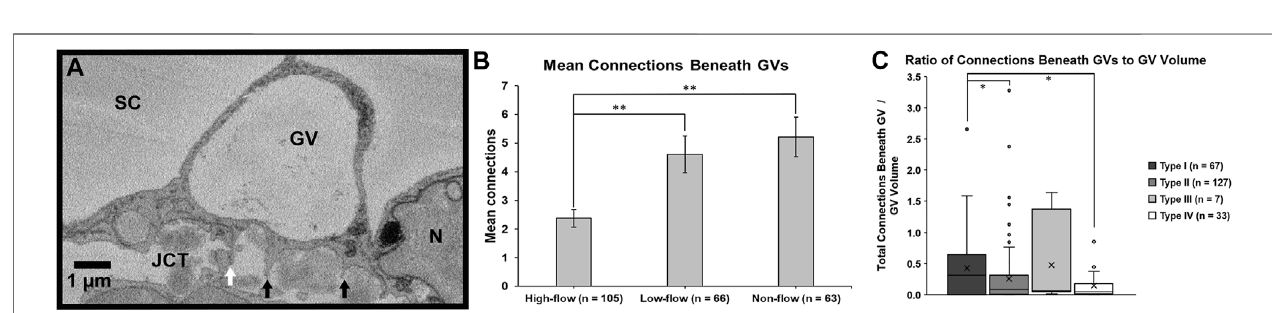
FIGURE 8 | Mean connections beneath giant vacuoles. (A) : Connections between Schlemm ’ s canal (SC) endothelial cells and underlying juxtacanalicular connective tissue (JCT) cells ( white arrow ) and matrix ( black arrows ) were identi fi ed beneath each giant vacuole (GV) and counted. N = endothelial cell nucleus. (B) : The mean number of connections beneath GVs in the cells in high- fl ow areas was signi fi cantly fewer compared to GVs in the cells in low- or non- fl ow areas (both p ≤ 0.01). Error bars : SEM. (C) : When standardized by volume and analyzed by type, Types IV and II GVs had signi fi cantly fewer connections per unit volume compared to TypeIGVs(both p =0.02).Type I:GVwithno basalopening orI-pore; TypeII: GVwithabasalopening,no I-pore; Type III:GVwithanI-pore, no basalopening;Type IV: GV with both basal opening and I-pore. Whiskers = 1.5 interquartile range (IQR). X = mean. * p < 0.05; ** p ≤ 0.01.